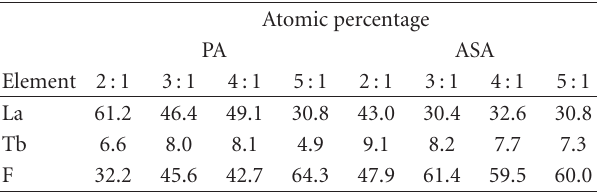
Table 2: Elemental composition and corresponding atomic per- centage of nanoparticles in PMMA at di ff erent ligand:nanoparticle ratios.